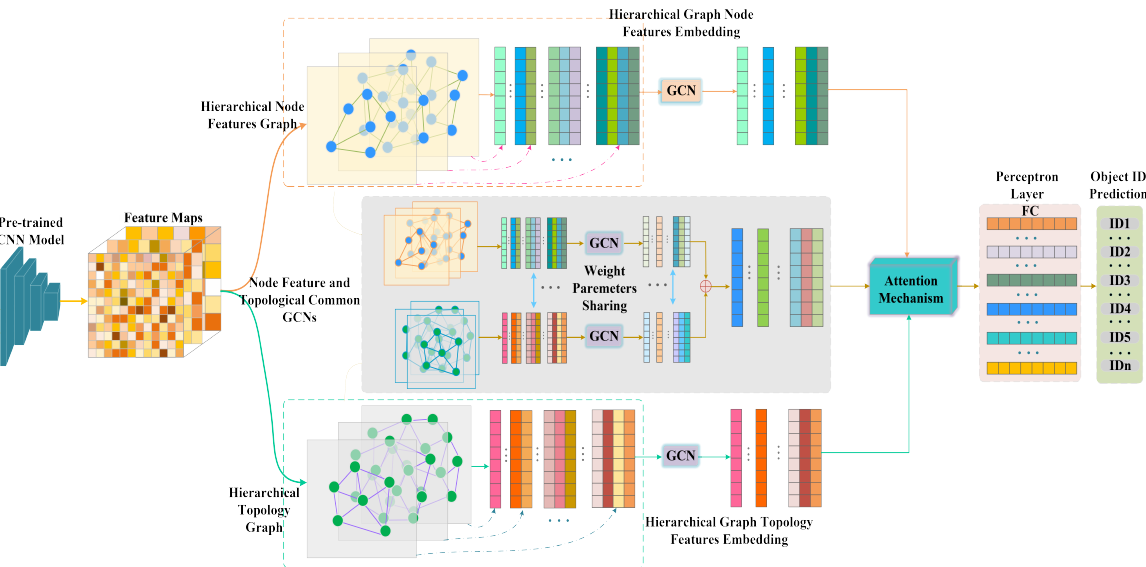
Figure 2. The whole architecture of our proposed AAD-CPGE framework of object